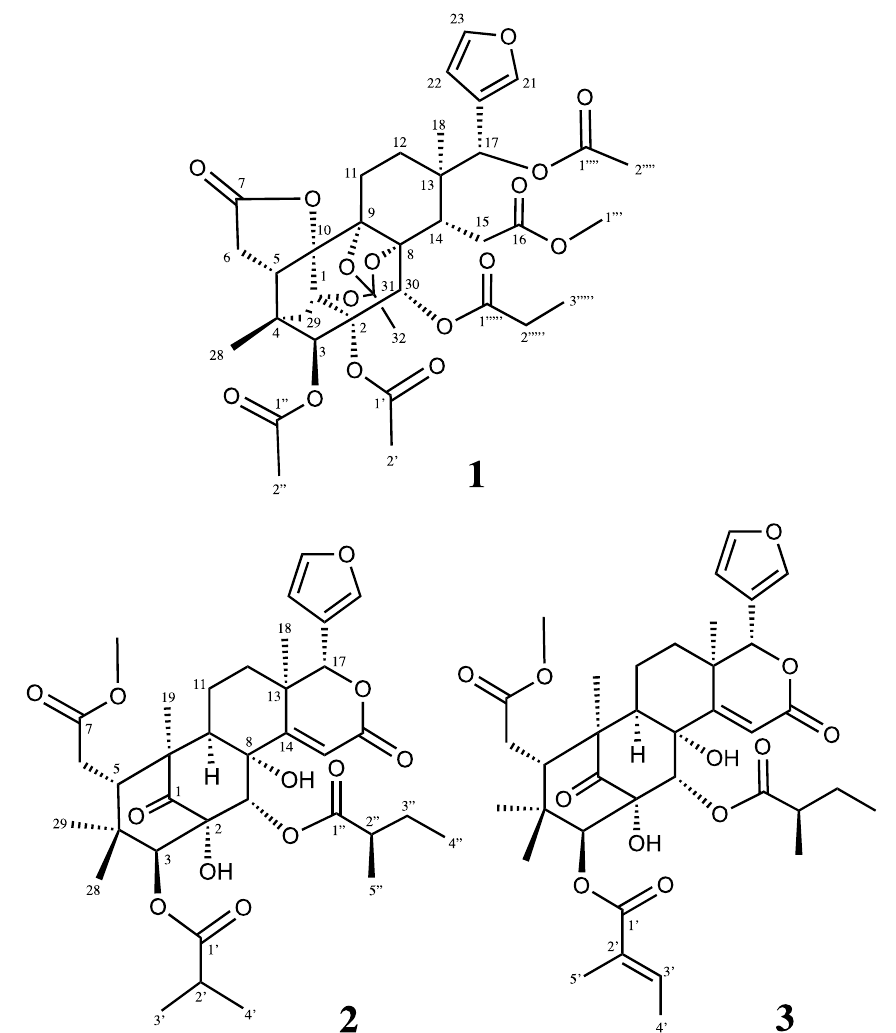
Figure 1 . Structures of compounds 1 – 3 from the seeds of C. guianensis .